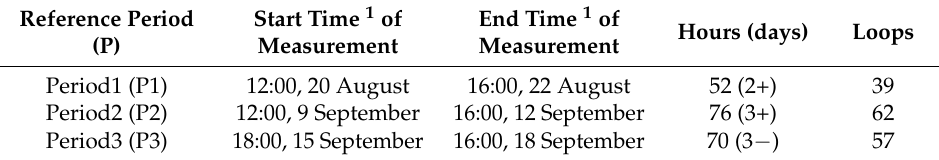
Table 1. List of the experiment periods and locations.